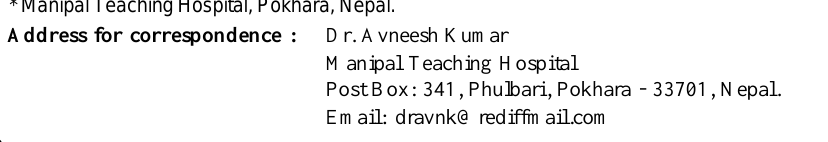
Fig. 1 : Clinical photograph showing swelling over the left nasomaxillary